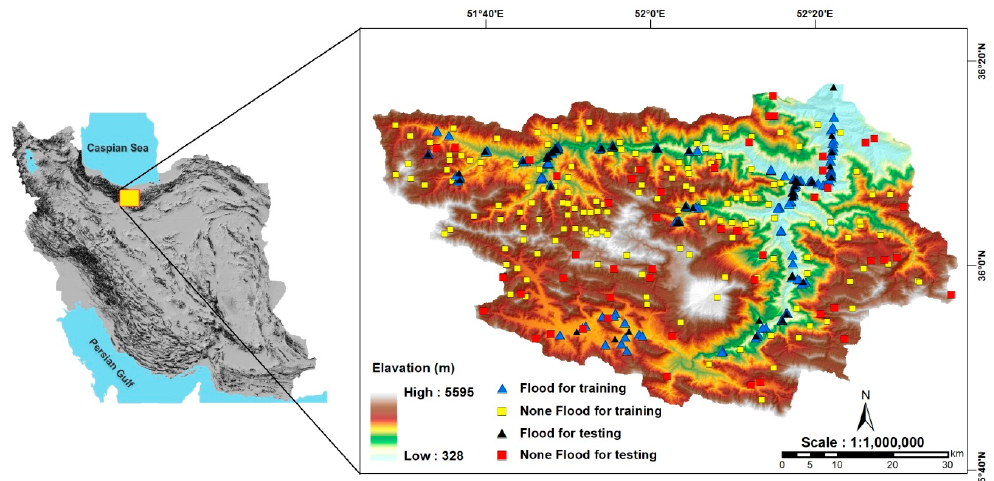
Figure 1. Flood inventory map and location of the Haraz watershed on Iran map.